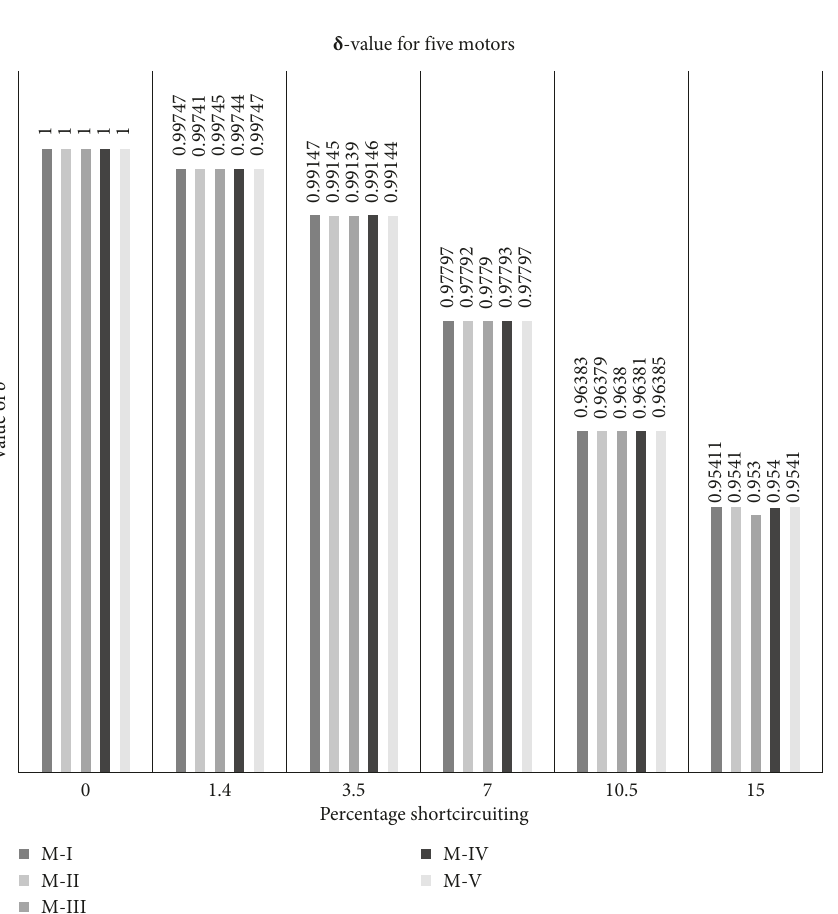
Figure 3: Variation of δ values at different interturn fault levels for motors (M-I to